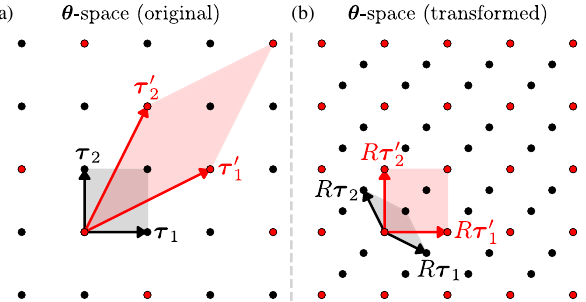
FIG. 3. Twisted TTS and action of linear transformation R on θ space for a specific m ¼ 2 example. (a) The lattice L of points (black) is defined by the translation vectors τ 1 ¼ 2 π ð 1 ; 0 Þ and τ 2 π ð 0 ; 1 Þ . The original driving Hamiltonian H ð θ Þ , Eq. (15), 2 ¼ has periodicity on the standard torus (grey shaded area). θ Þ generally has different The interaction Hamiltonian H int ð periodicity. We show an example where the periodicity is on a sheared torus (red shaded area), given by the translation vectors τ 0 2 π ð 2 ; 1 Þ and τ 0 2 π ð 1 ; 2 Þ , which defines a lattice L 0 1 ¼ 2 ¼ (red points). (b) Invertible linear transformation R mapping θ ↦ R θ so that ð τ 0 τ 0 ↦ ð R τ 0 τ 0 τ τ 1 ; 2 Þ . The Hamilto- 1 ; 2 Þ 1 ; R 2 Þ ¼ ð nian H 0 ð θ Þ ≔ H int ð R − 1 θ Þ has periodicity on the standard torus int (red shaded area) and additionally has g τ twisted TTSs H 0 ð θ þ R τ Þ ¼ g τ H 0 ð θ Þ g † τ , where τ ∈ 2 π Z 2 int int